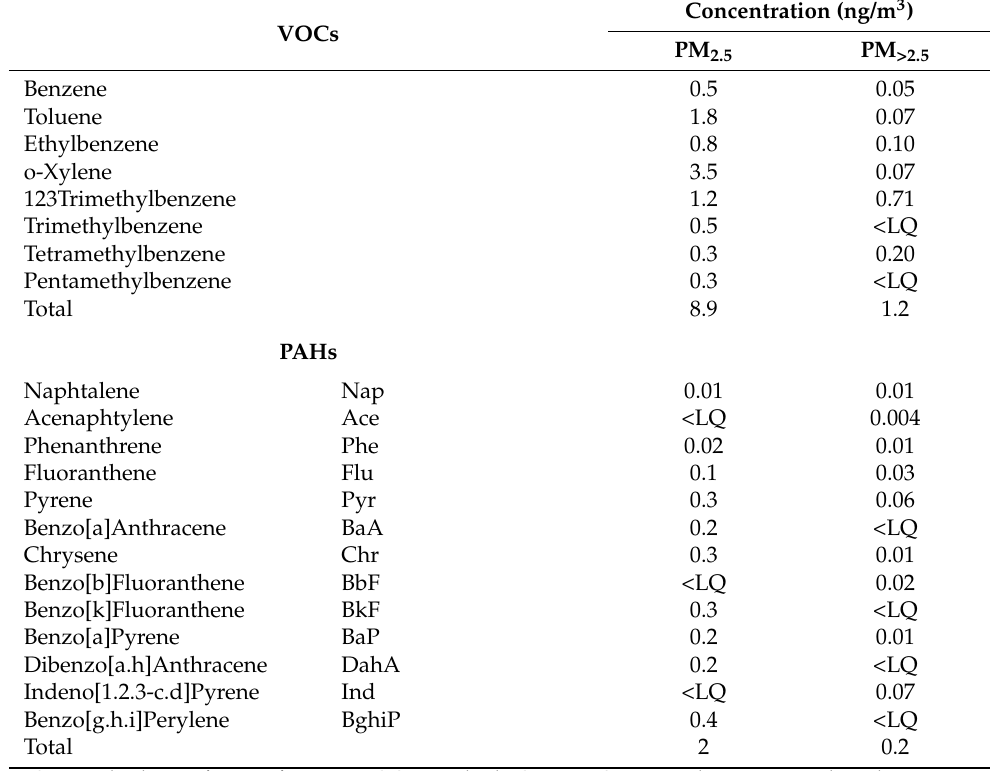
Table 5. Organic compounds in the two air pollution PM